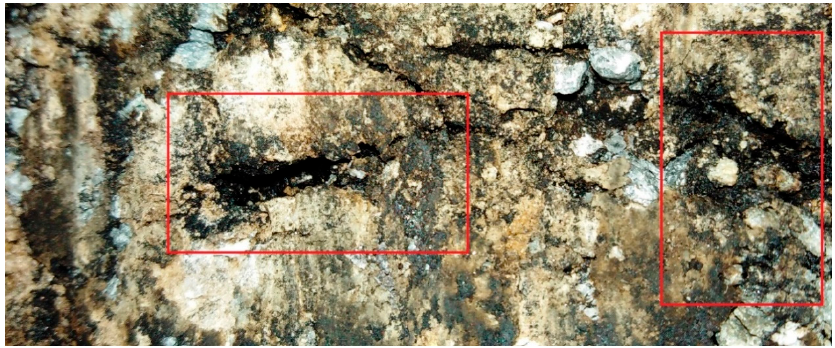
Figure 6. Cavities between aggregates in Marshall specimens.